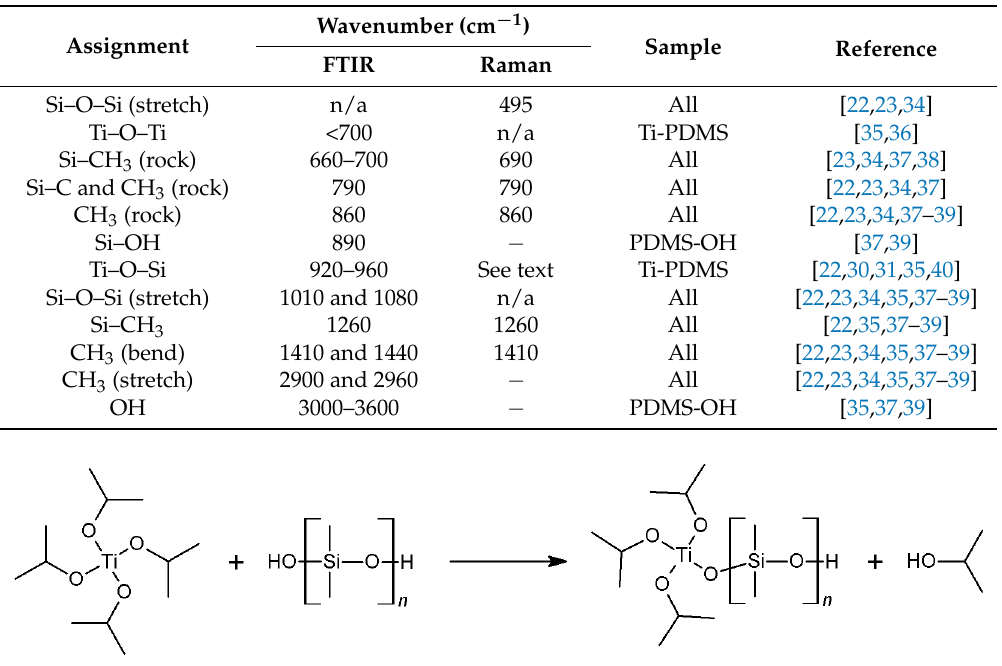
Figure 3. Scheme of the initial step involved in the reaction of TIP with PDMS-OH. The remaining isopropoxy groups can further react with PDMS-OH or with TIP to form titania-like domains.